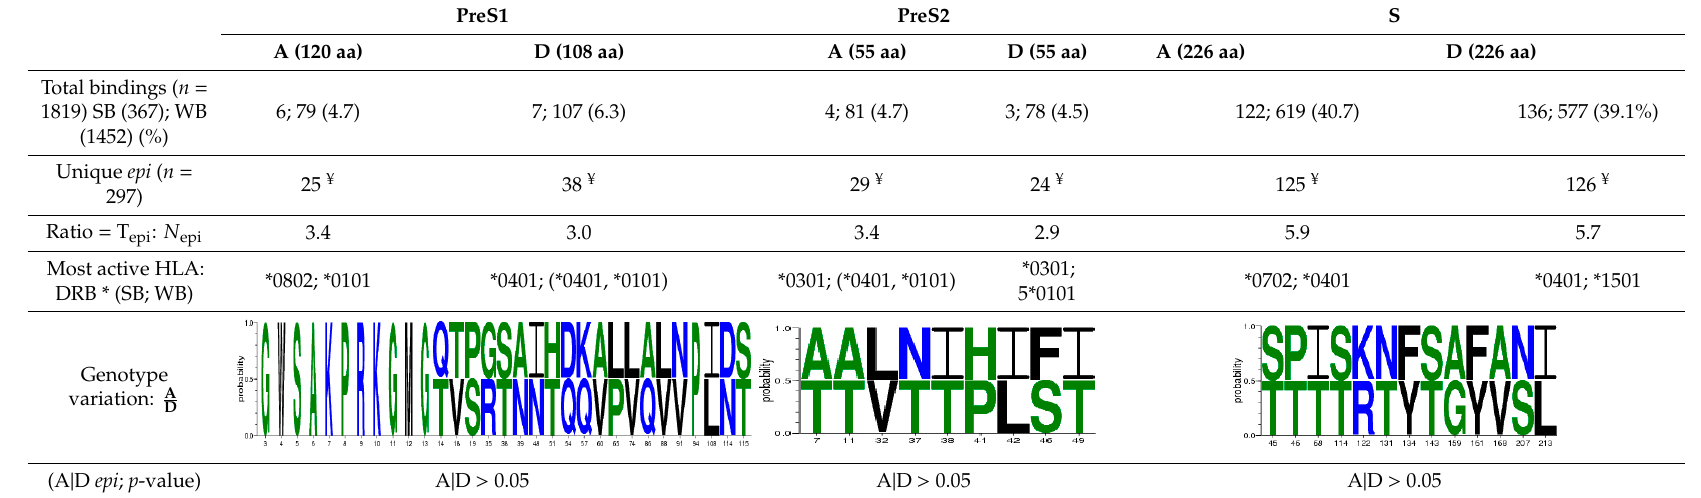
Table 1. Distribution of T cell epitopes restricted to 9 HLA class II alleles with high population coverage in Botswana. PreS1 PreS2 S